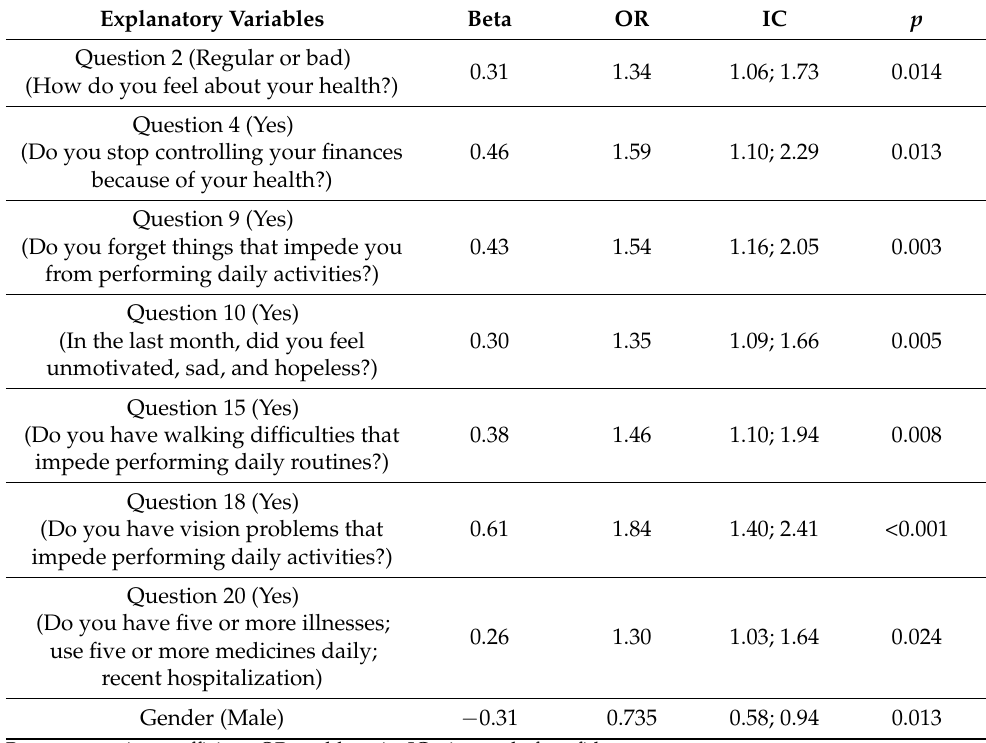
Table 2. Questions included in the adjusted regression equation model selected to identify older adults with and without fall